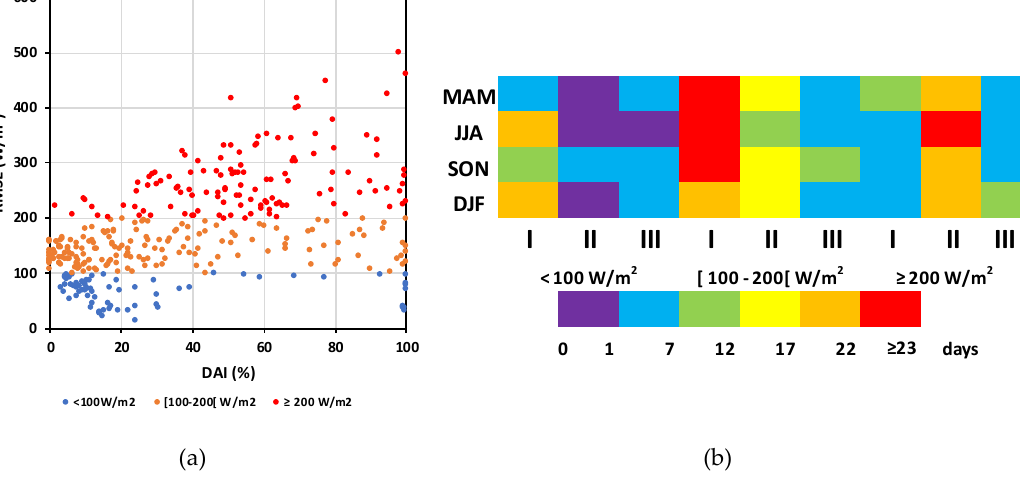
three ranges of values), obtained for each day, from hourly raw values. Day type class (I ‐ clear, II ‐ partially cloudy, and III ‐ overcast) is obtained following the WMO guidelines [23].